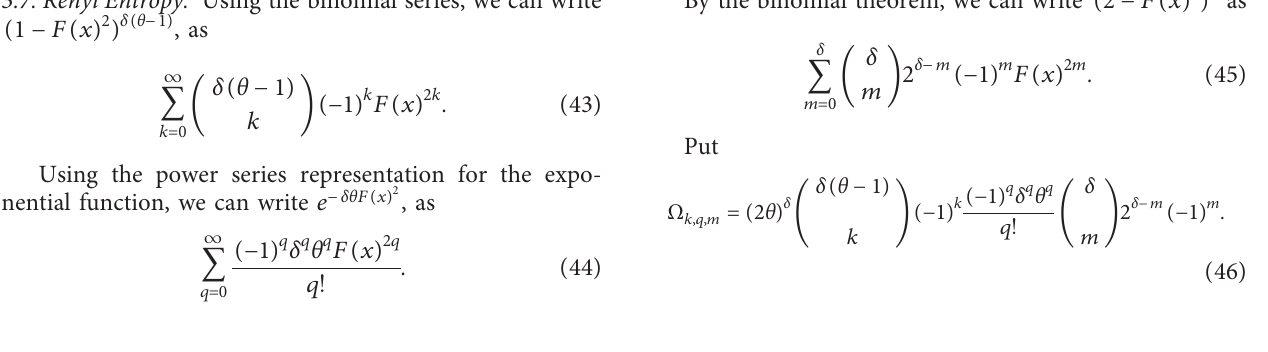
Plot of bias vs. n